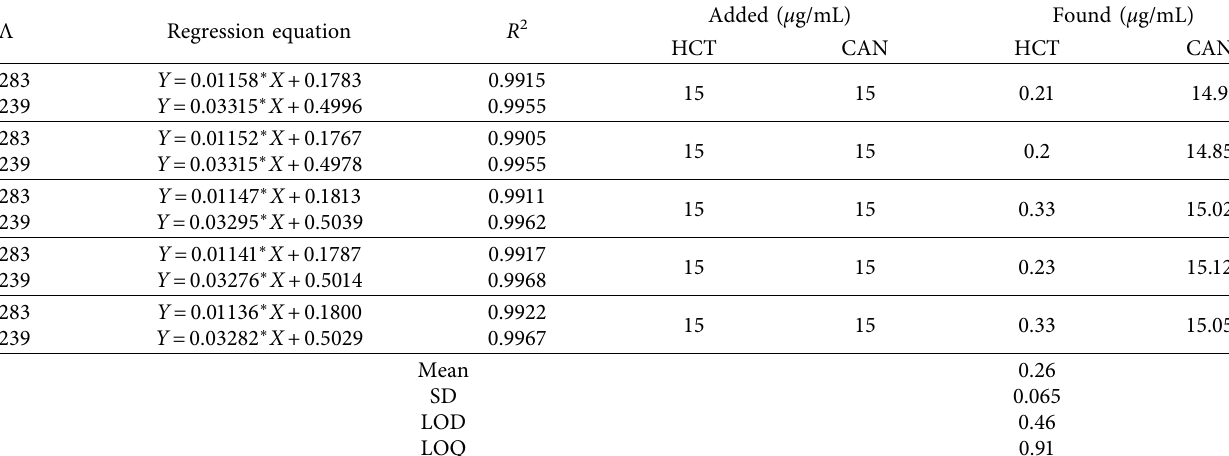
Table 2: Limit of detection (LOD) and limit of quantifcation (LOQ) of HCT by HPSAM.